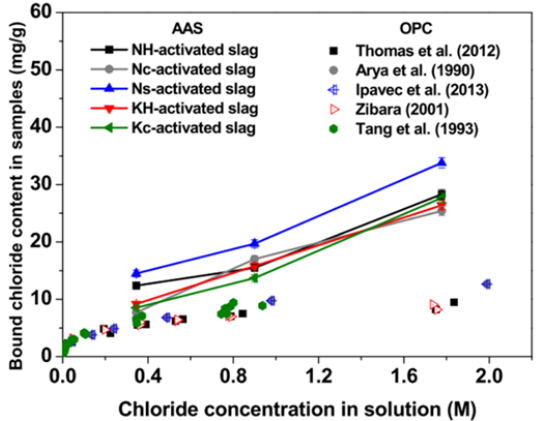
Figure 8. Chloride-binding isotherms of hardened slag-based AAMs pastes with various types of activator [18,134–138].